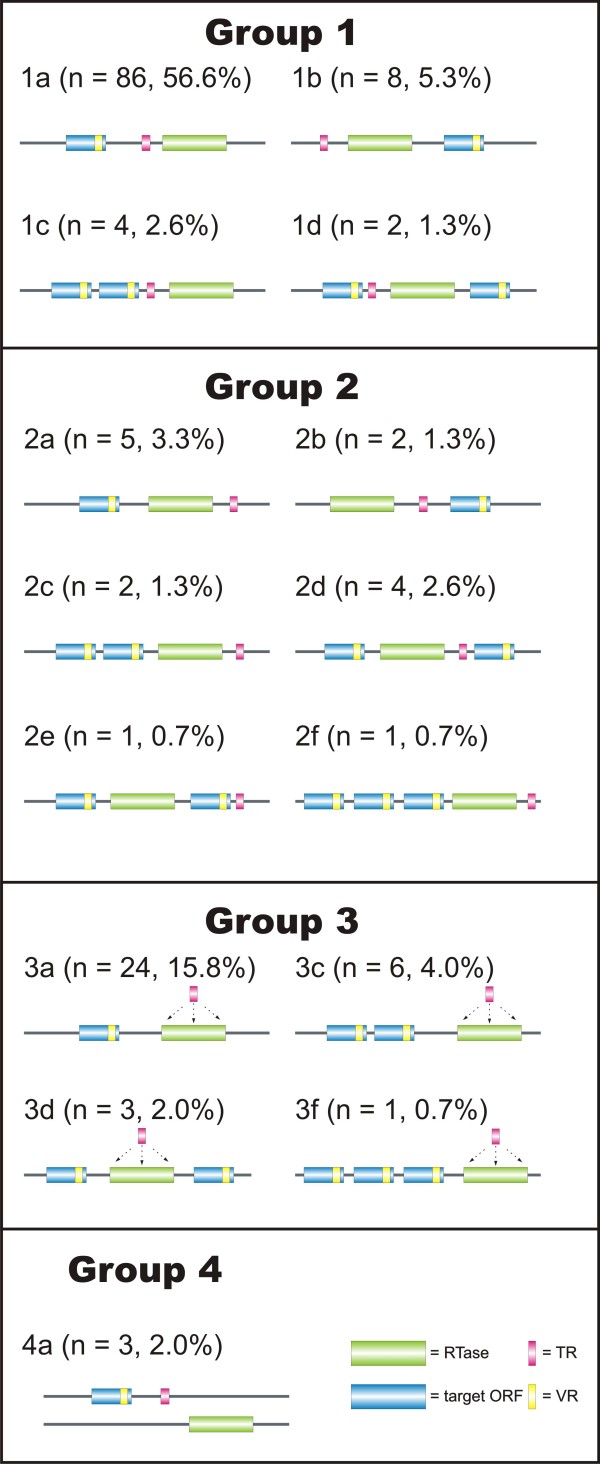
Structural diversity of DGRs. Arrangements of DGR elements was determined and DGRs were classified into four main groups and respective subgroups. The number and fraction of hits per subgroup is given in parentheses. RT ORFs are shown in green and target ORFs in blue, TRs are depicted in pink and VRs in yellow. Some subgroups (1e, 1f, 3b, 3e, etc.) were not observed in our data set and are thus missing in this figure.